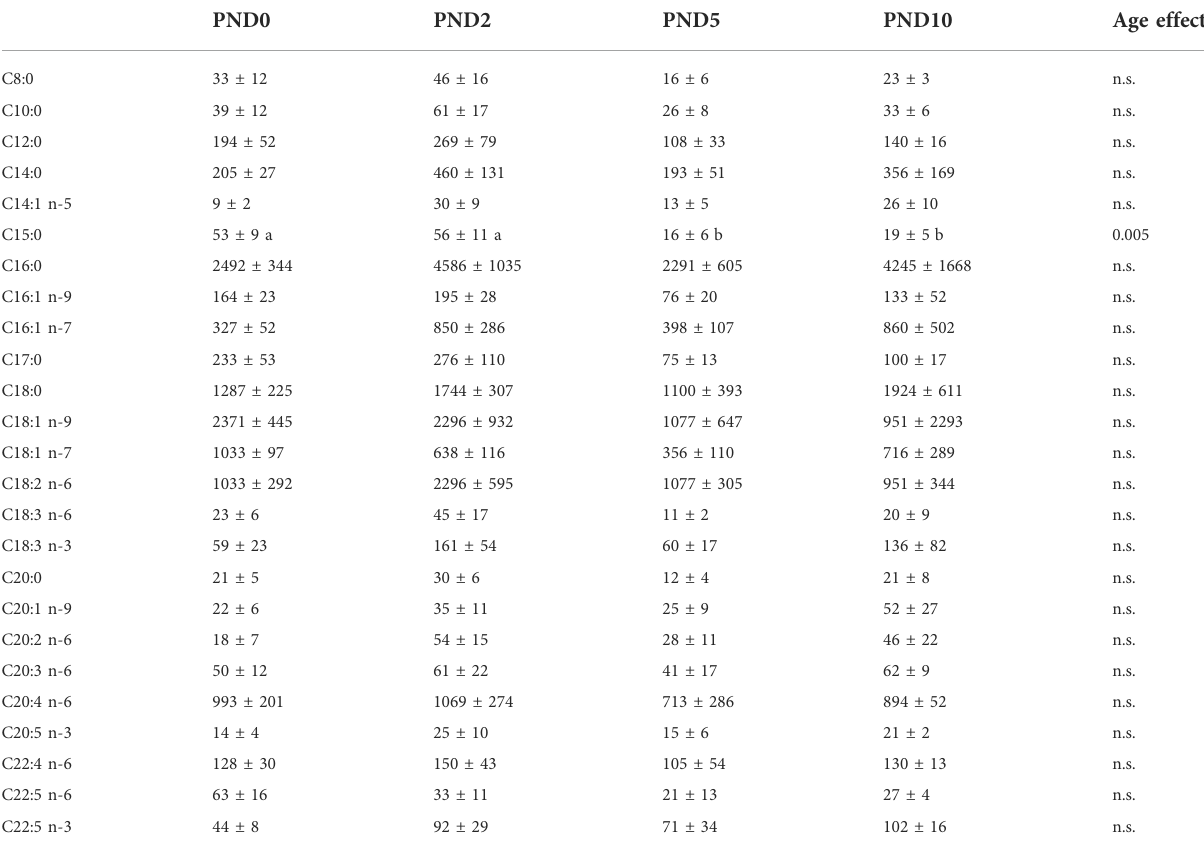
TABLE 4 Fatty acid composition (µg/g) of antrum during the neonatal